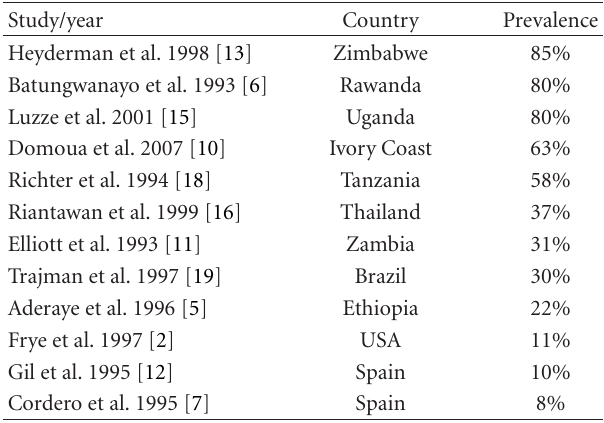
Table 2: Reported prevalence rates of HIV-pleural tuberculosis across various